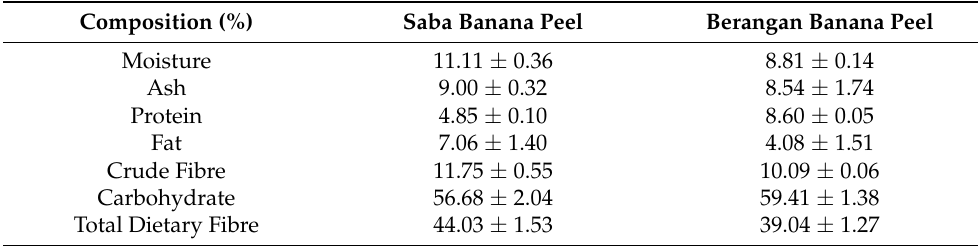
Table 2. Proximate composition and TDF of banana peel